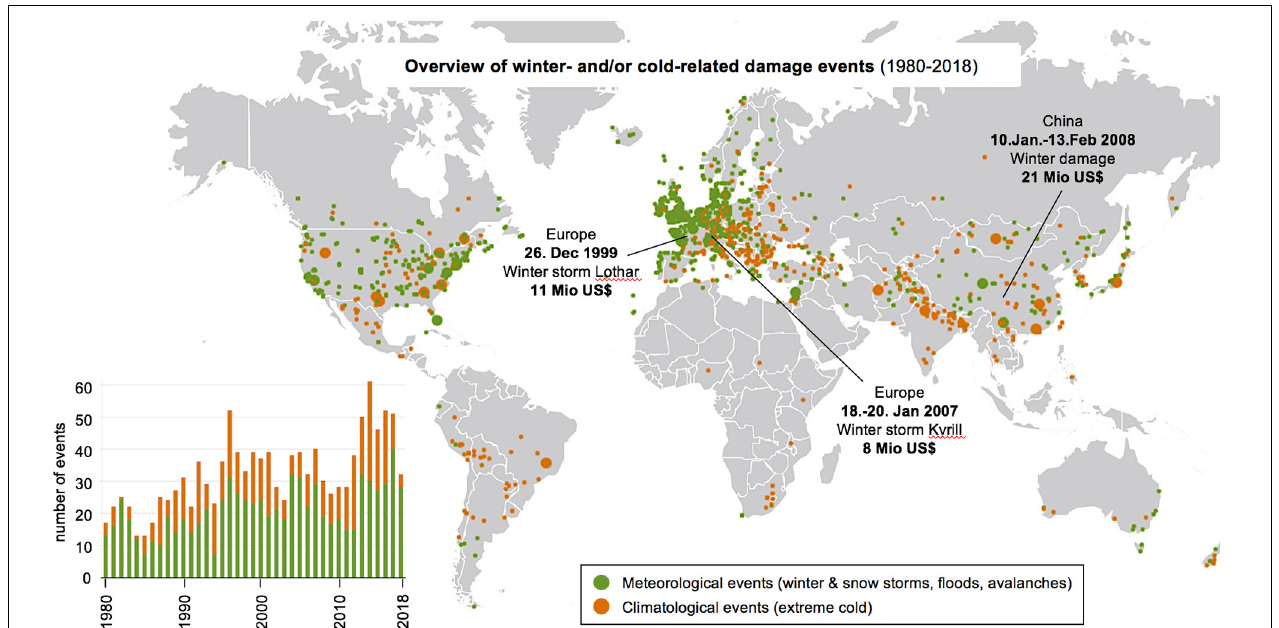
FIGURE 1 | Summary of winter storm and winter damage events from 1980 to 2018. Data were retrieved from the public database provided by Munich RE NatCatSERVICE in July 2020. The world map shows the location where damage occurred with meteorological events in green and climatological events in orange. Highlighted are the three most costly single events in this time span, with the costs of damage in Mio US$. The bar chart on the left shows the number of worldwide events per year.